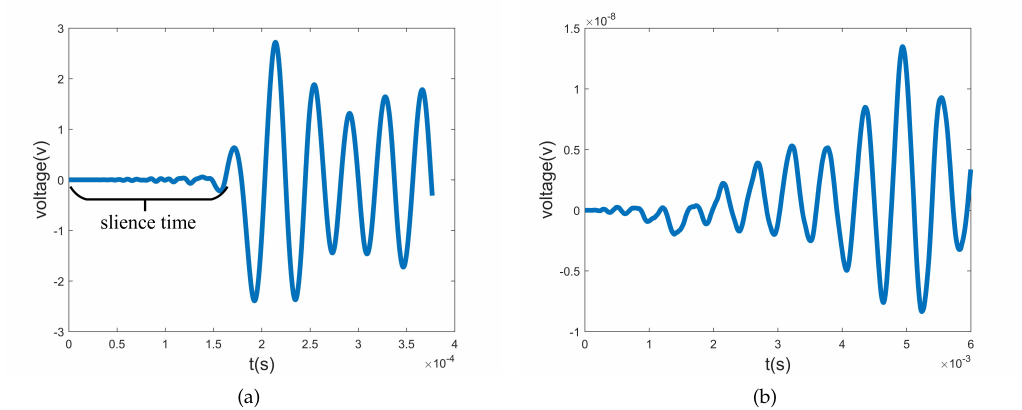
Figure 21. Voltage responses of L 0 sensor excited by ( a ) L 0 and ( b ) F 6 waves. The silence time area is nearly five cycles.